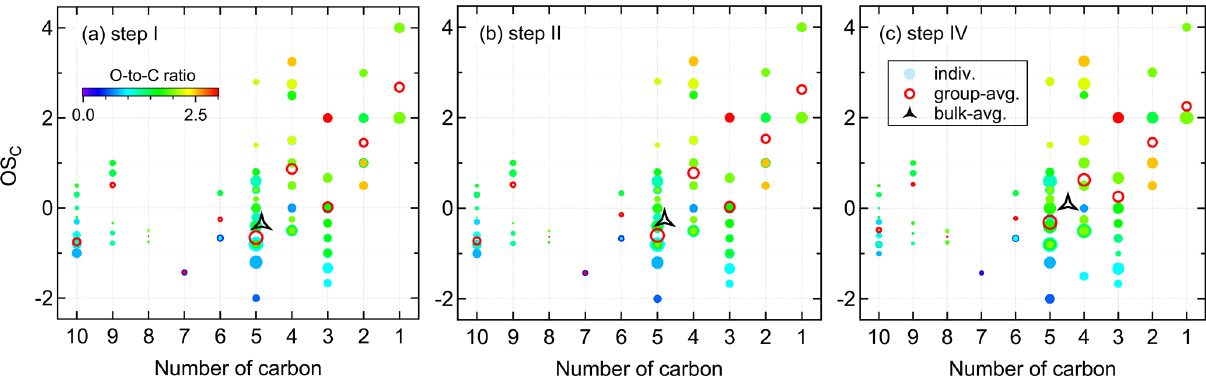
Figure 4. Distribution of gas-phase products from isoprene oxidation by NO 3 in the carbon oxidation state (OS C ) versus carbon number ( n C ) space. Markers are colored by oxygen-to-carbon molar ratio and sized by the logarithm of peak areas. The group-averaged and bulk- averaged OS C are the signal-weighted mean average carbon oxidation state of compounds with the same carbon number and of all detected compounds,